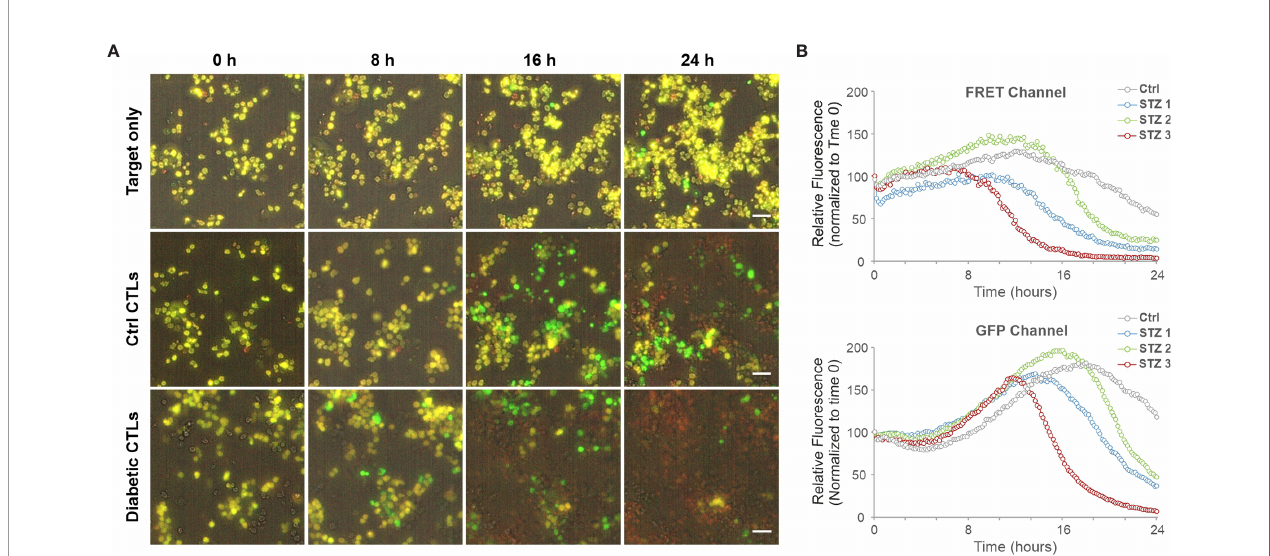
FIGURE 3 | CTLs from diabetic exhibit faster killing kinetics. 3D killing assay was carried out to determine killing kinetics at 37°C with 5% CO 2 every 10 minutes for 24 hours. EG7-pCasper cells were used as target cells, which were embedded in collagen (2 mg/ml). CTLs were added from top. CTLs from STZ-3 mouse is shown in (A) . The quanti fi cation of the signal from FRET or GFP channel is shown in (B) . Scale bars are 40 m